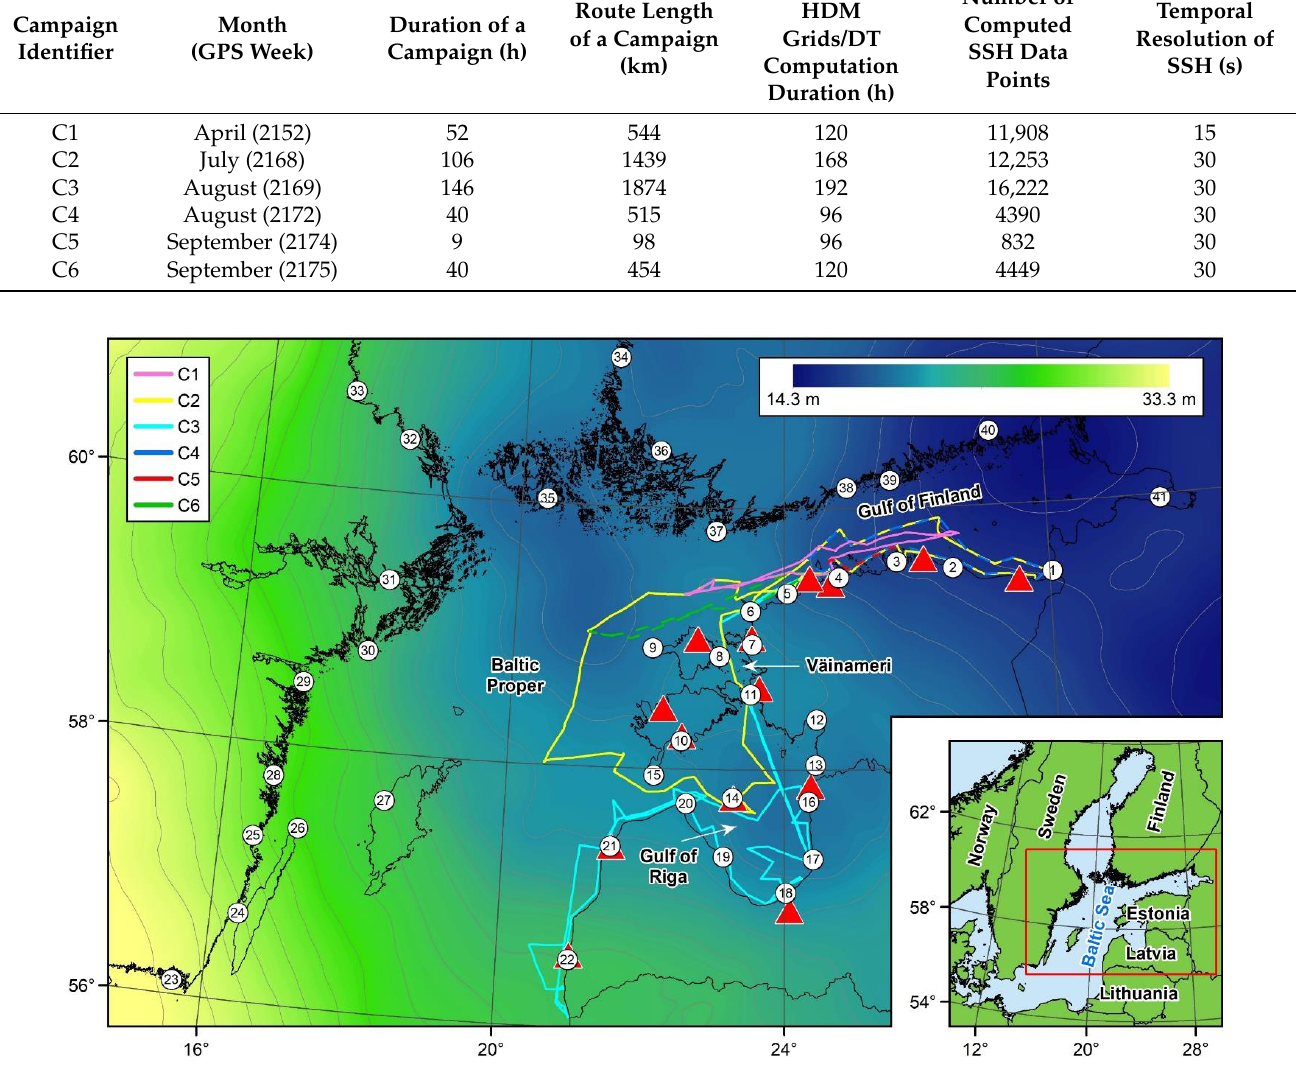
Figure 2. Study area (see the red rectangle) and routes of marine survey campaigns. Numbered circles denote the used TG stations, and red triangles continuously operating reference stations that were employed for GNSS post-processing. Colored background and grey isolines (contour interval is one meter) depict the NKG2015 quasigeoid model.